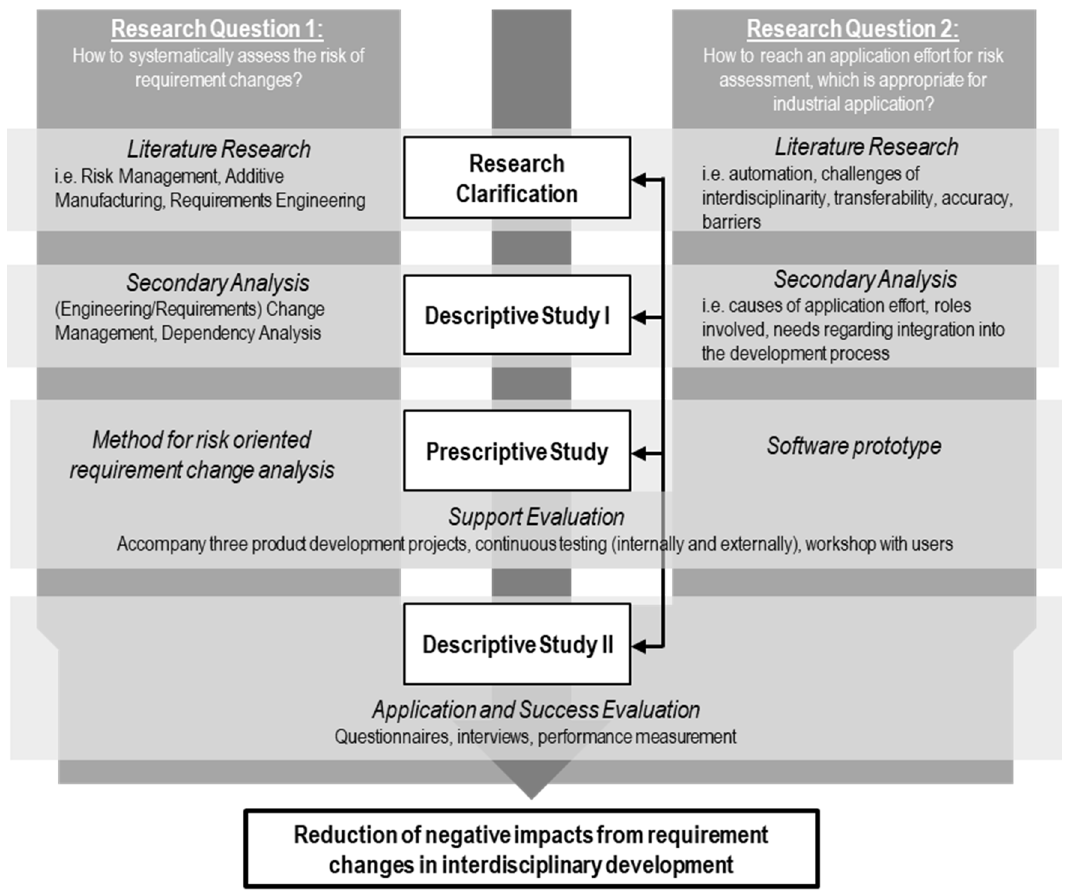
Figure 5. Research approach based on [47].